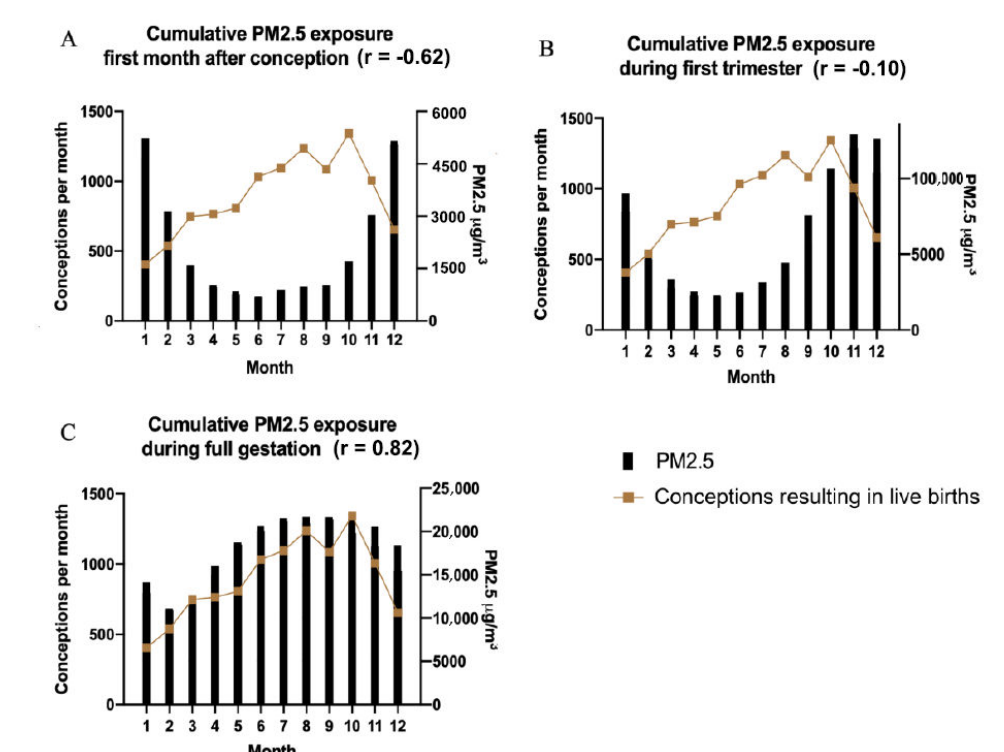
Figure 5. Cumulative daily maternal exposure to PM 2.5 during the first month of pregnancy ( A ), the first trimester ( B ) and full gestation ( C ).